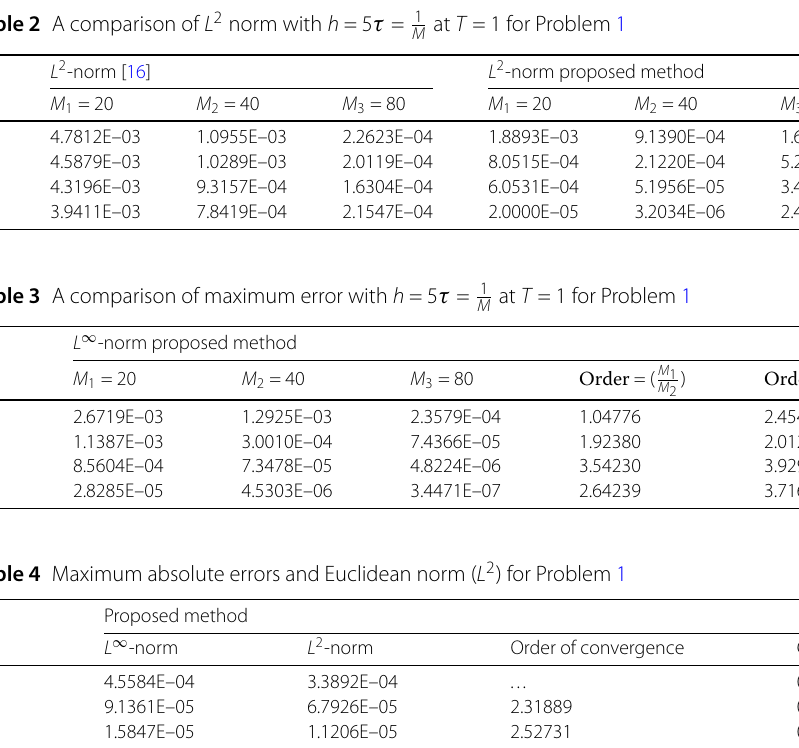
at T = 1 for Problem 1 M